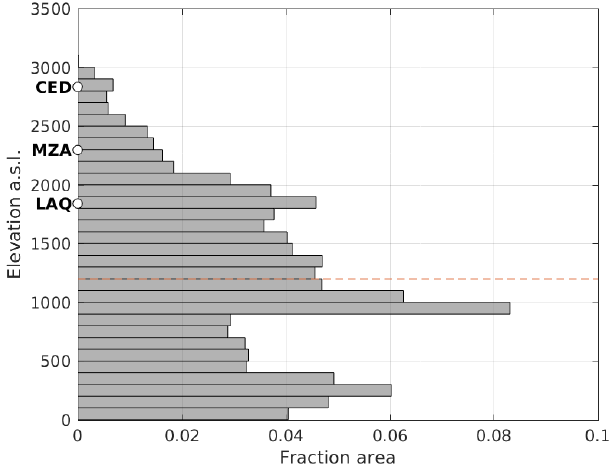
Figure 2. Elevation histogram of the simulation domain (in me- ters above mean sea level) including the position of the AWS. The dashed line indicates the reference elevation, which is gener- ally considered as the lower winter snowline elevation in Mount Lebanon, i.e., the elevation below which the snow cover is virtually absent